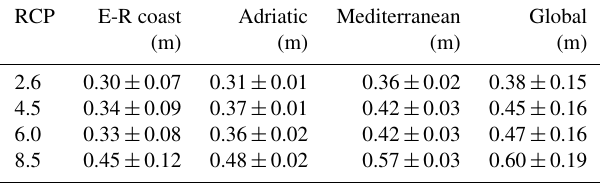
Table 2. Sea level predicted during the time interval 2081–2100 with respect to 1986–2005, according to the four IPCC AR5 RCPs. The Adriatic and Mediterranean values are averaged values across these seas. These projections do not include the GIA component of sea-level change.